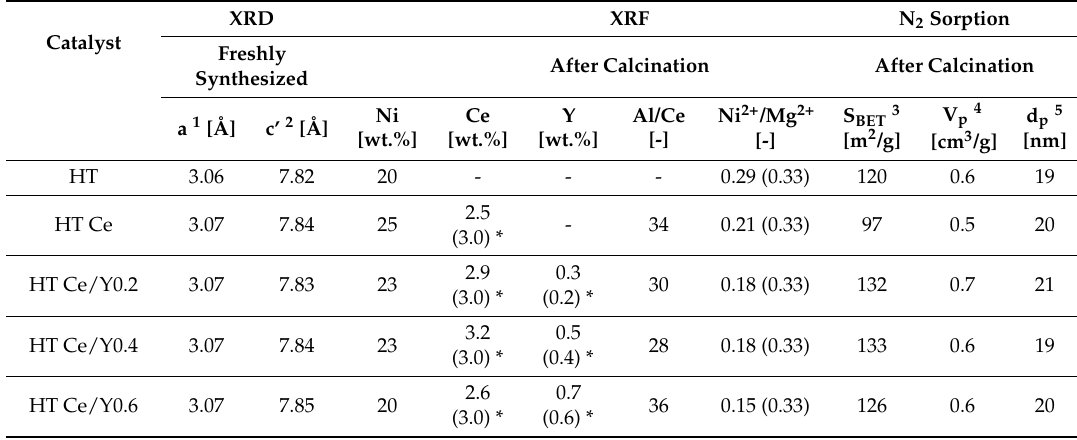
Table 1. Structural parameters, elemental composition, and textural